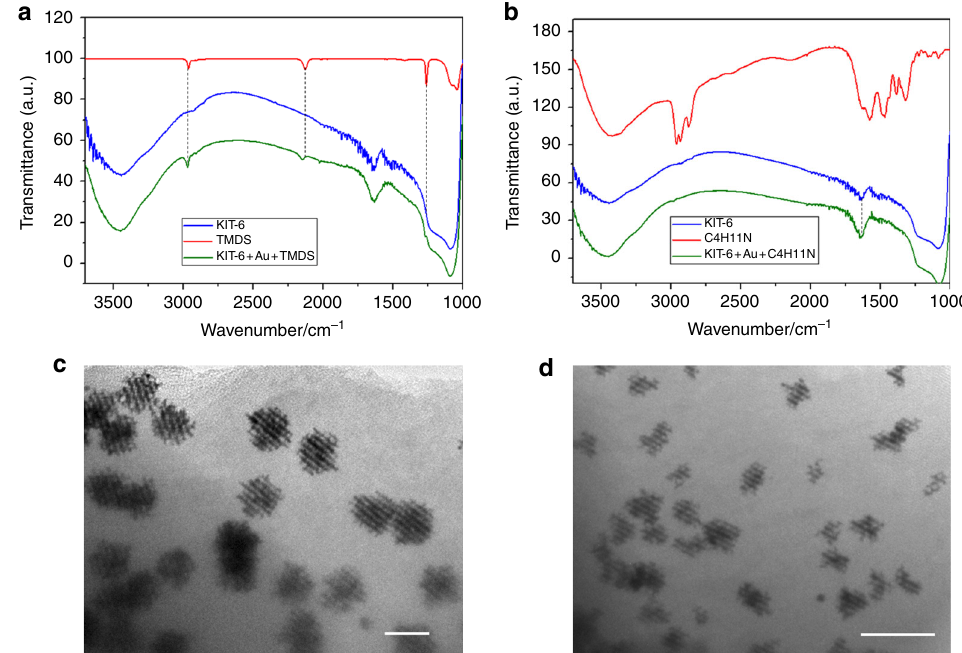
Fig. 4 The in fl uences of the reduction agent and solvent barrier layer. a FT-IR spectra of the KIT-6 mesoporous template, TMDS reduction agent, and Au compounds. b FT-IR spectra of the KIT-6 mesoporous template, butylamine reduction agent, and Au compounds. c 3D mesoporous Au networks/silica compounds using butylamine as the reduction agent and hexane as the solvent (scale bar, 100 nm). d 3D mesoporous Au networks/silica compounds using TMDS as the reduction agent and dichloromethane as the solvent (scale bar, 200